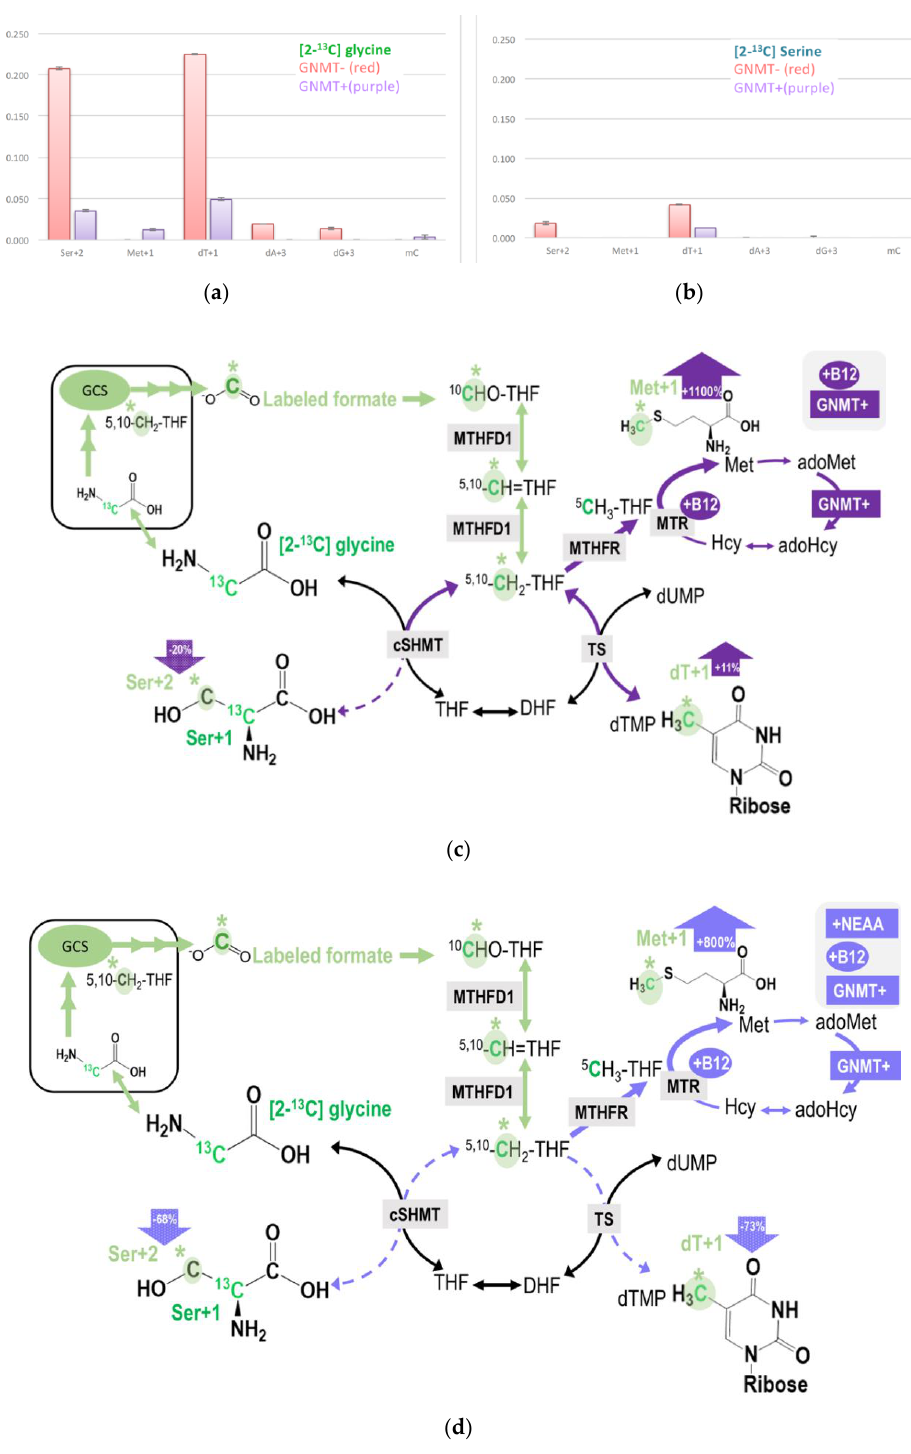
Figure 4. ( a , b ) Restoring GNMT expression significantly decreased isotopic enrichments in target metabolites originated from the C-2 carbon of glycine via GCS. ( c ) Vitamin B12 supplementation increased GCS-derived formate utilization in dTMP and methionine syntheses, but decreased this 1C used in cytosolic serine formation from glycine in GNMT + cells. ( d ) NEAA supply decreases GCS-derived formate utilization in both GMNT + and GNMT − cells. The original glycine tracer is marked in green, and the recycled glycine 2-carbon from the GCS is marked in light green with a * mark for ( c , d